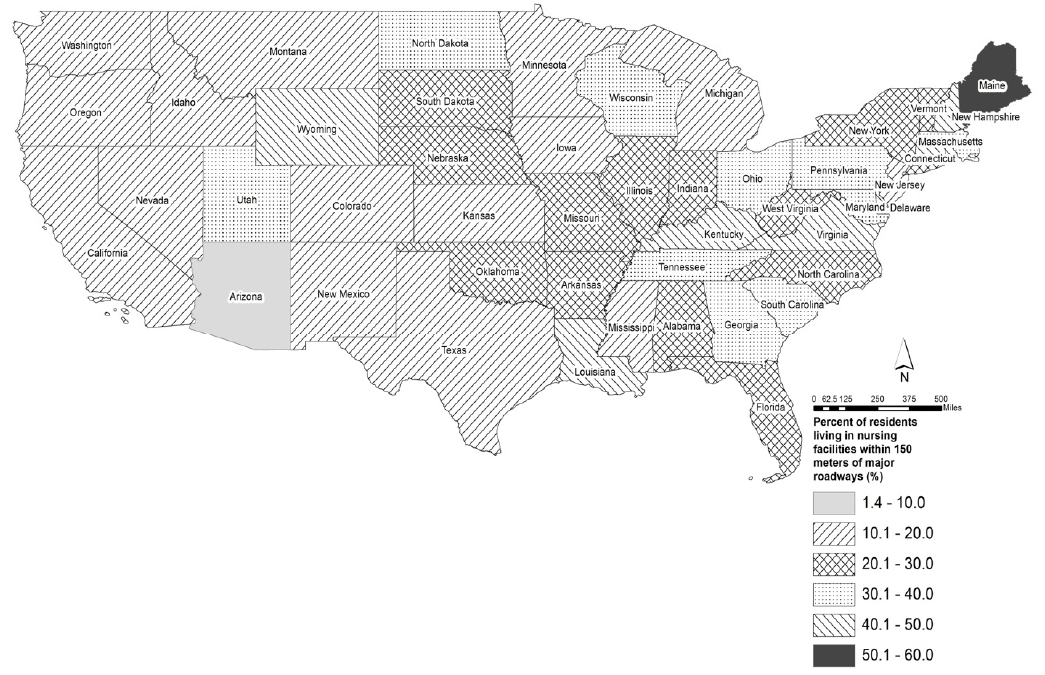
Figure 2. Percent of residents living in nursing facilities located near (within 150 m of) major roadways (A1 or A2) in the 48 contiguous U.S. states.